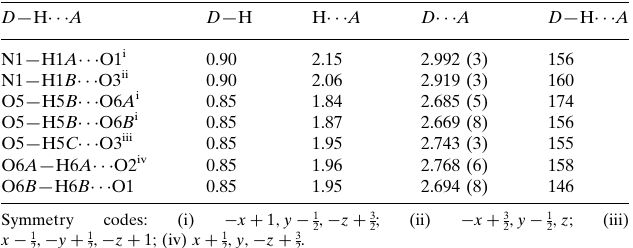
Hydrogen-bond geometry (A˚ , (cid:5)